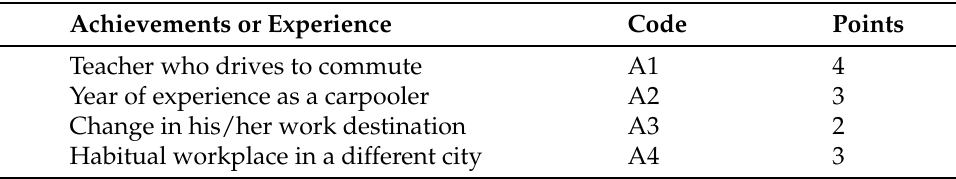
Habitual workplace in a different city